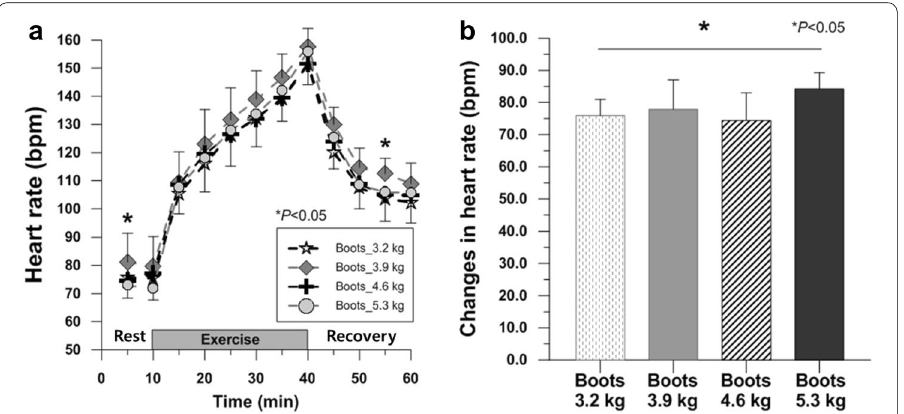
Fig. 3 Time courses of heart rate ( a ) and changes in heart rate ( b ) during exercise. * P < 0.05, ** P < 0.01, and *** P <